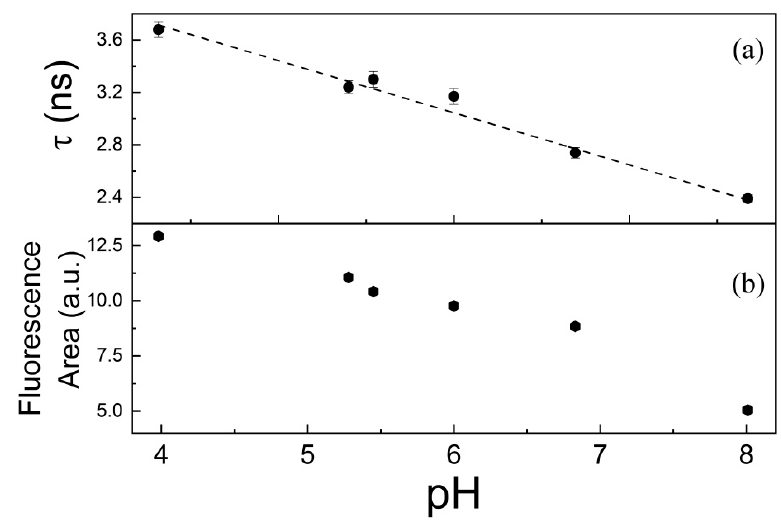
Figure 7. ( a ) Fluorescence lifetime values for natural dye that was extracted as a function of pH at 460 nm, and ( b ) the area of fluorescence spectra (AFS) from measurements that were performed at 532 nm. The dashed adjustment is shown for eye guidance only.